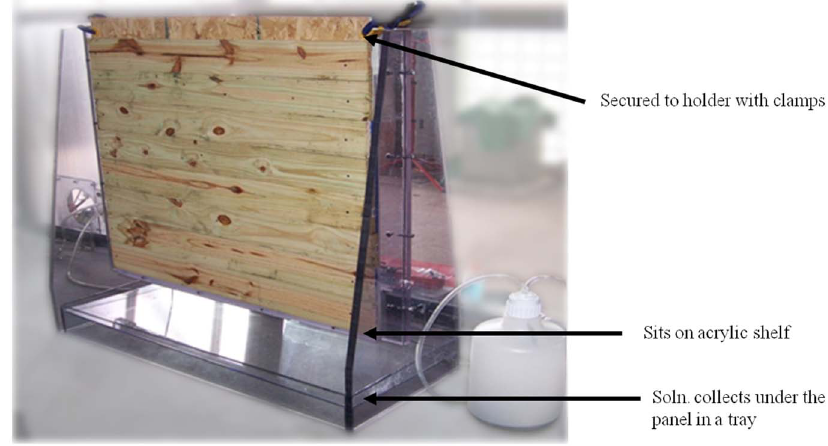
Figure 1. Sampling flow chart.